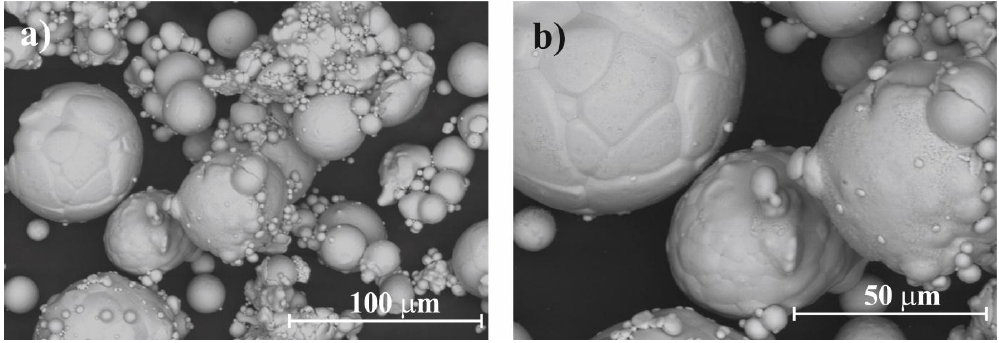
Figure 1. ( a , b ) SEM micrographs of the copper powder at different magnifications.